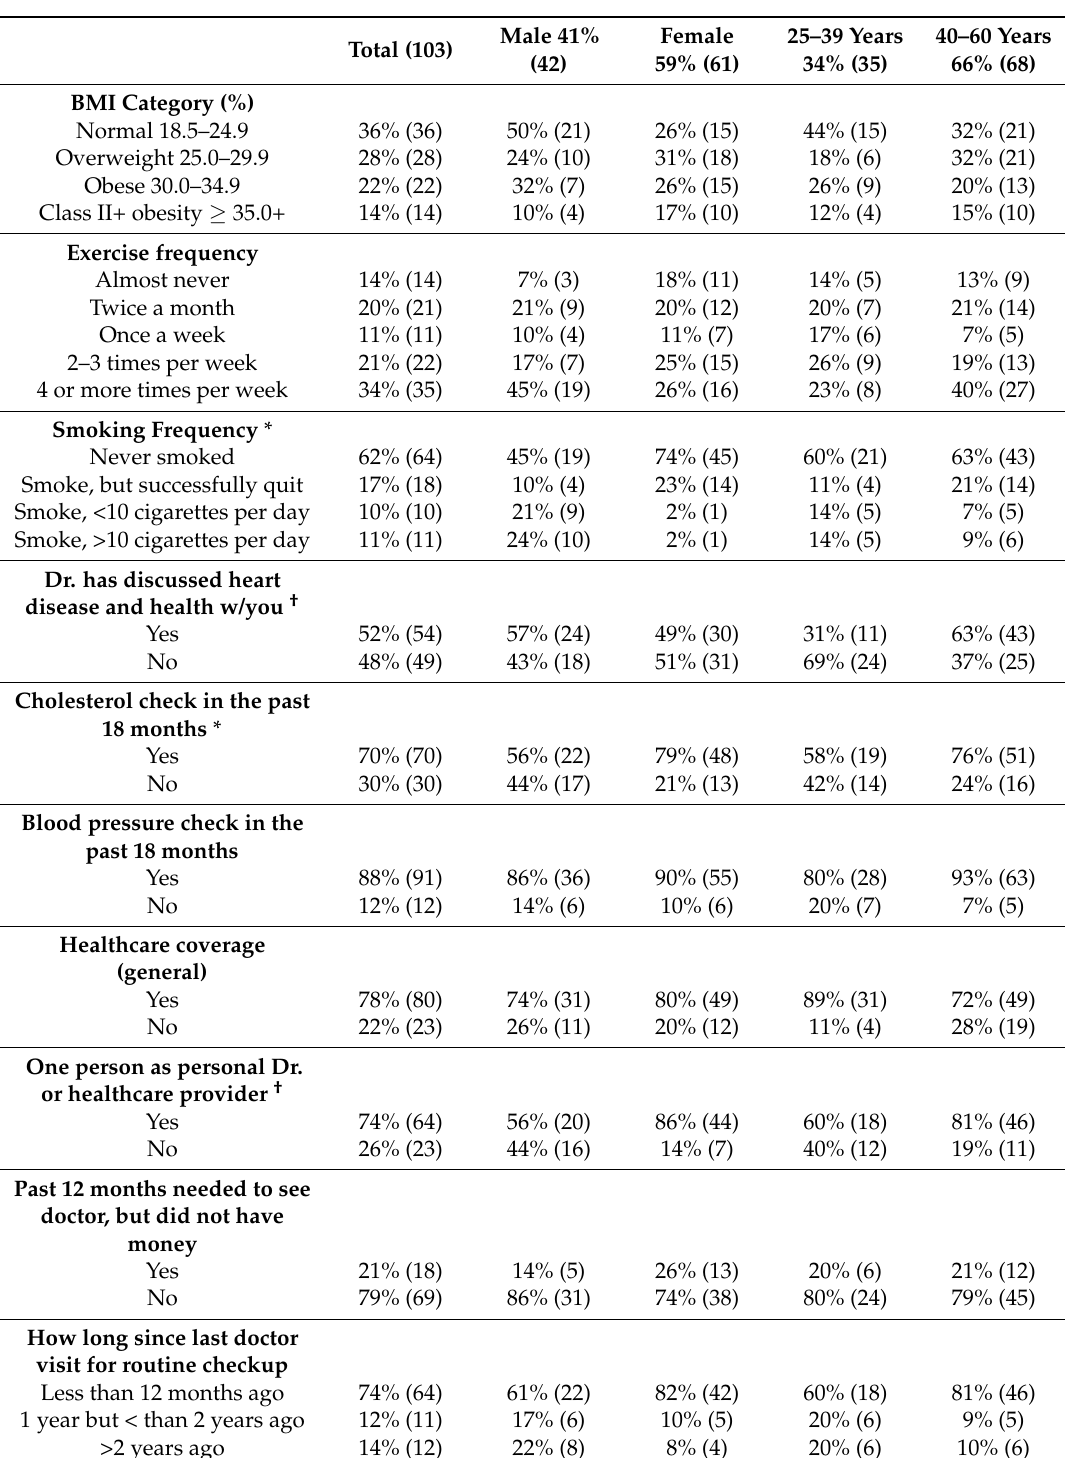
Table 2. Health behavior characteristics of focus group participants [ n = 103; m ± SD; % ( n